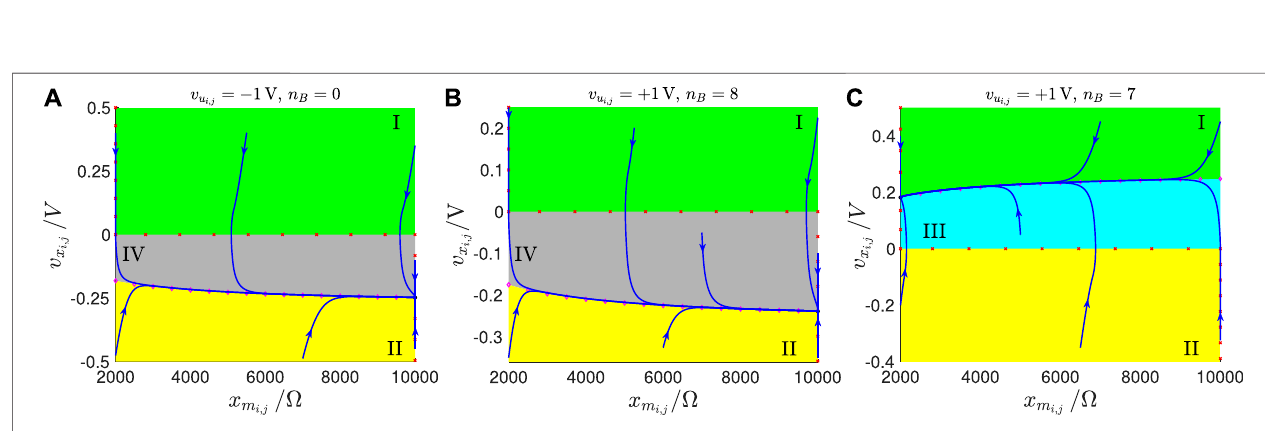
FIGURE 14 | (A) SDP of a cell C ( i , j ) featuring the input voltage v u (cid:1) + 1V in the only scenario of rule 2 (in the worst-case scenario n voltage v u i , j